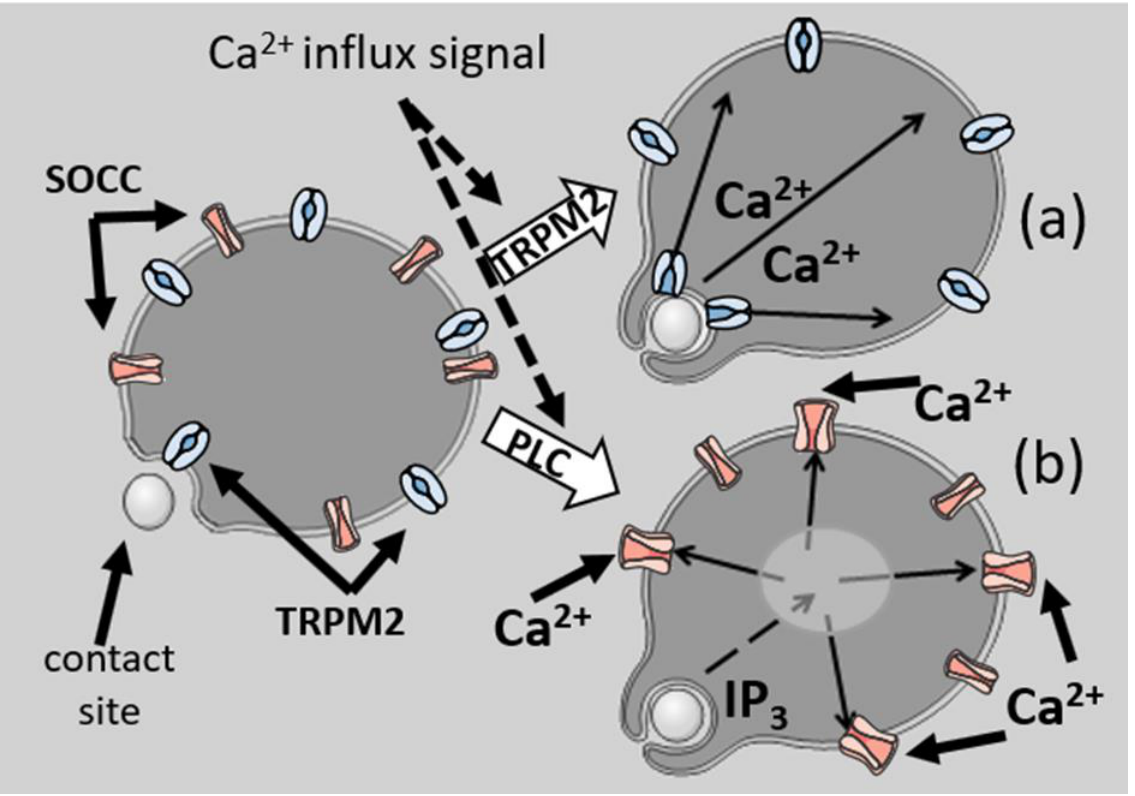
Figure 3. The effect of the two routes of Ca 2+ signalling on retaining information as to its locus of origin.